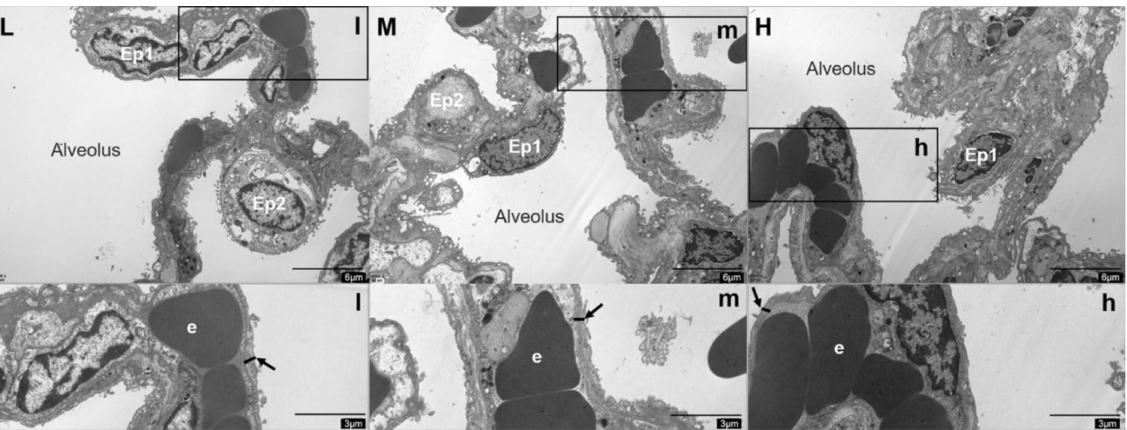
Figure 6. Alveolar septum ultrastructure at low (L), middle (M), and high (H) altitudes under 6000 × field of view. Type I epithelial cell (Ep1), type II epithelial cell (Ep2), and erythrocyte (e) are shown, arrows indicate air-blood